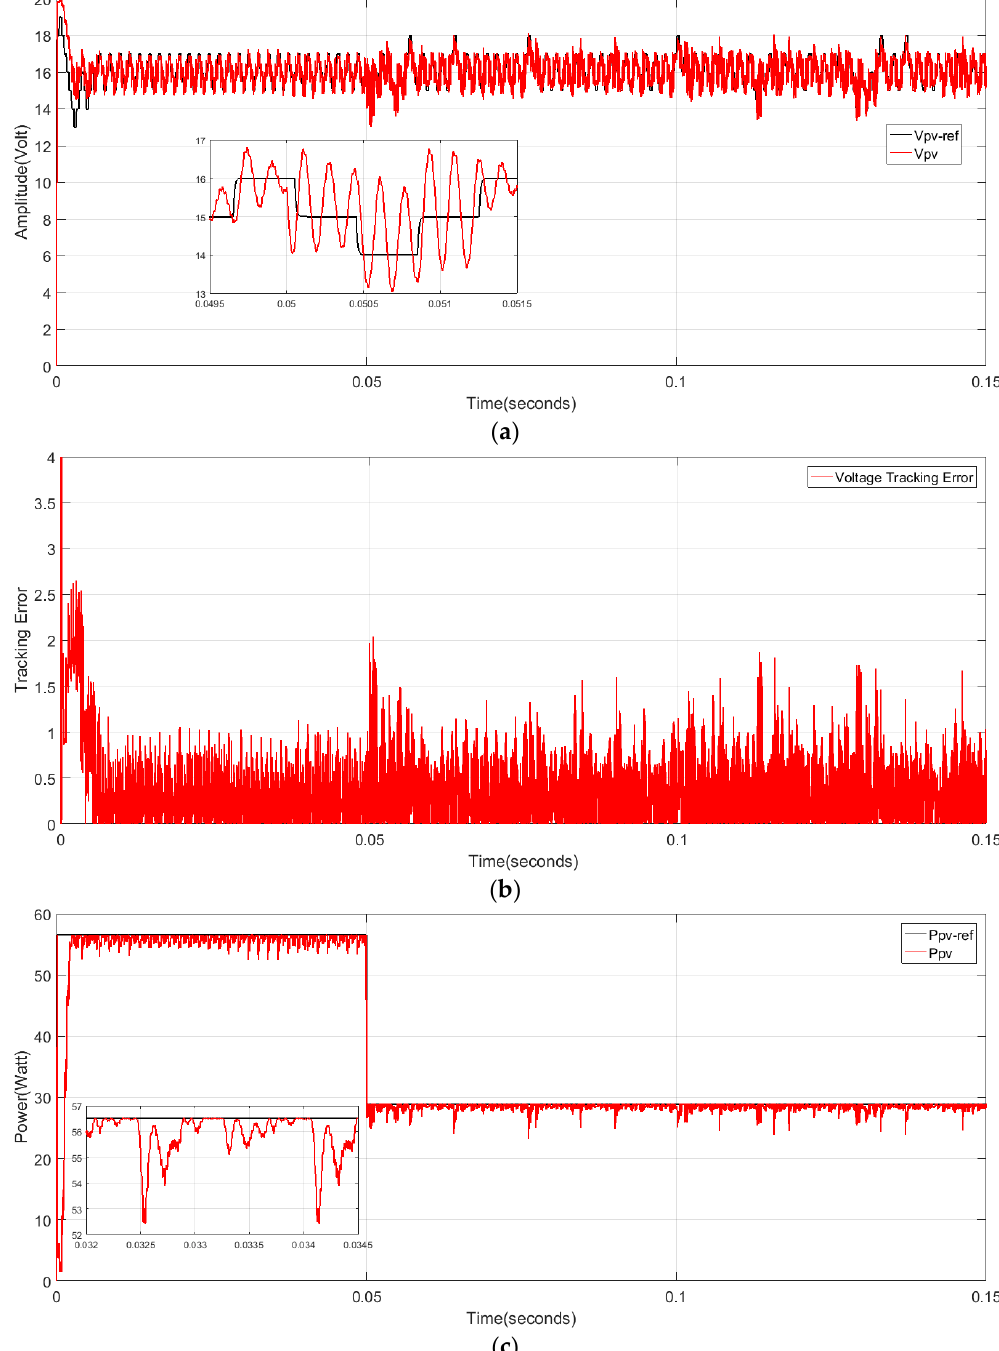
Figure 5. ( a ) Profile of the PV panel voltage, ( b ) tracking response of the proposed PID controller, and ( c ) profile of the PV power extraction.